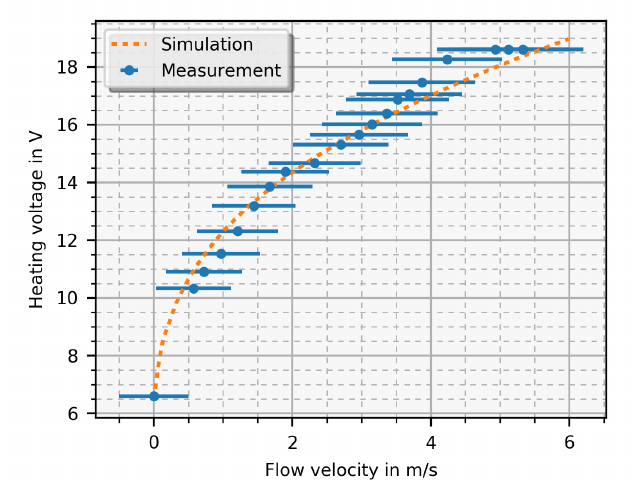
Figure 9. Measurement of the PCB sensor in constant temperature mode compared with the simulation. The heater voltage is plotted as a function of the mean flow velocity where the error bars indicate the error ( ± 0.5m/s+ 7%from